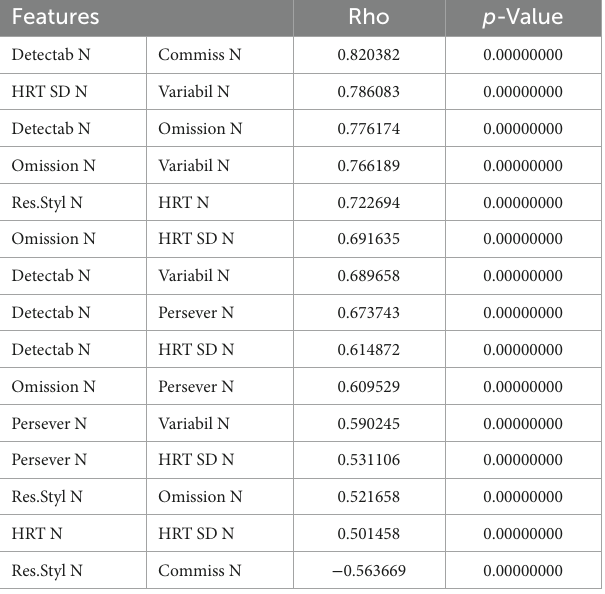
TABLE 4 Rho values > abs(0.5) for variables with high correlation in group P (diagnosed ME/CFS).